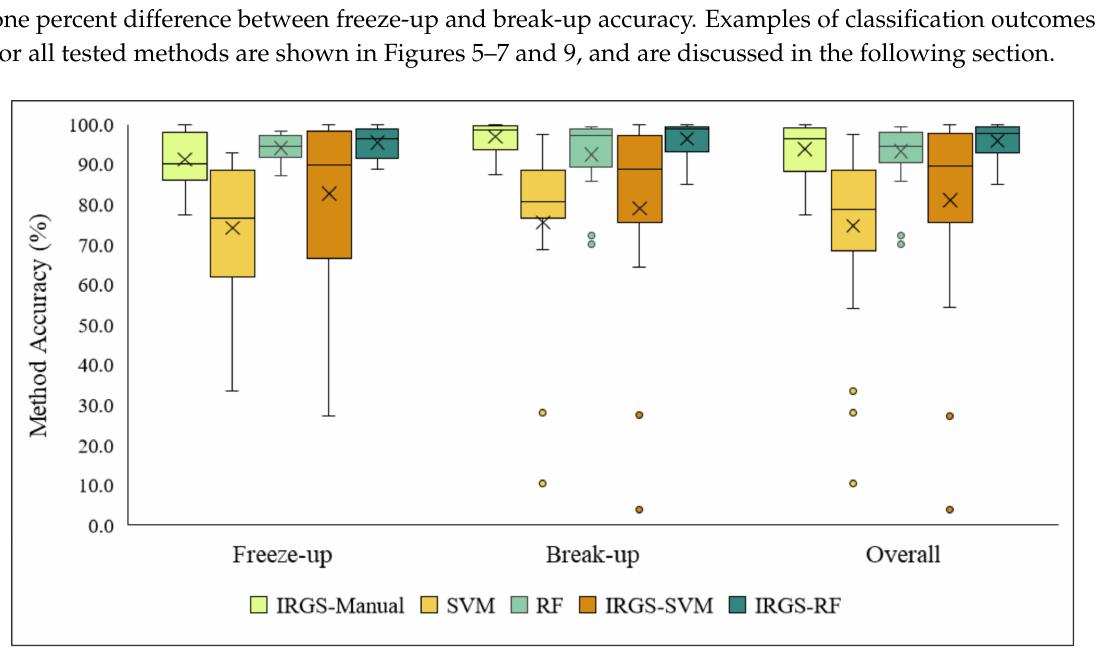
Figure 4. Box and whisker plots showing the distribution of classification accuracy values resulting from each method for the tested scenes overall (36 scenes) and by period (20 and 16 for freeze-up and break-up respectively). Mean is represented by “x”. Outliers which exceed a value of 1.5 times below the first quartile are represented by